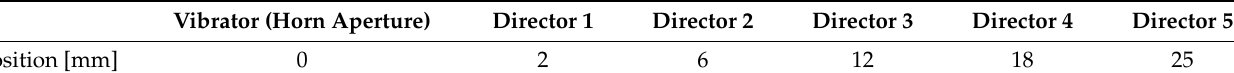
Table 2. Finding the position of the FSS layers with respect to the horn aperture.